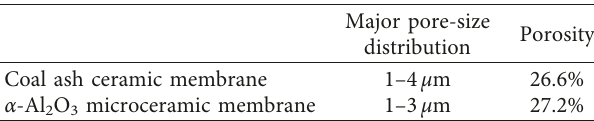
Major pore-size Porosity distribution